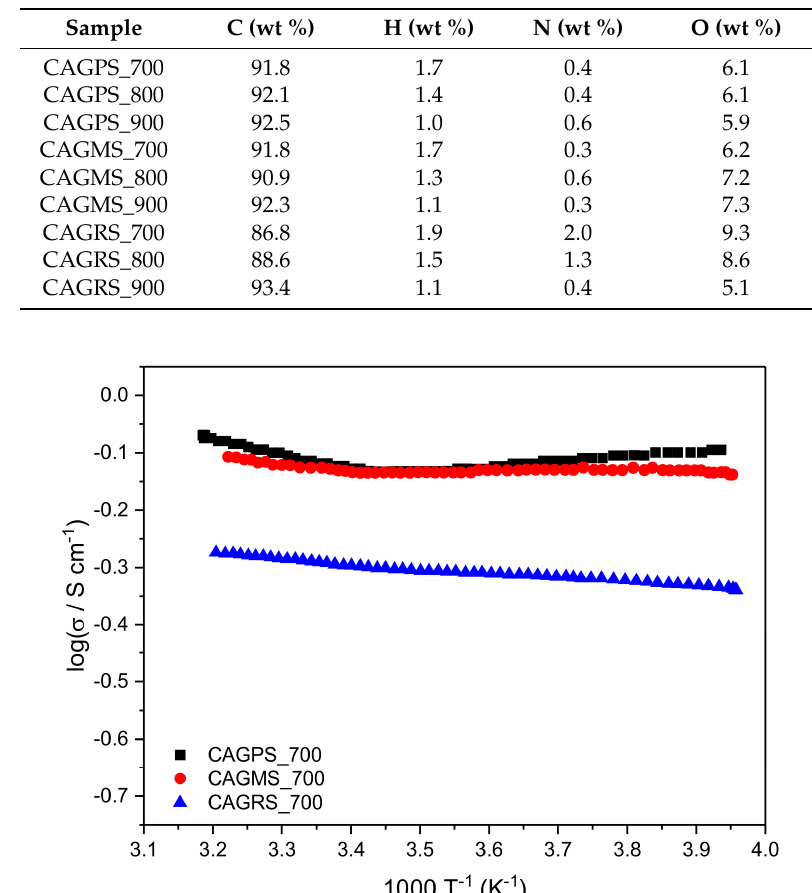
Figure 5. The Arrhenius plots of CAGPS, CAGMS, and CAGRS materials carbonized at 700 ◦ C.